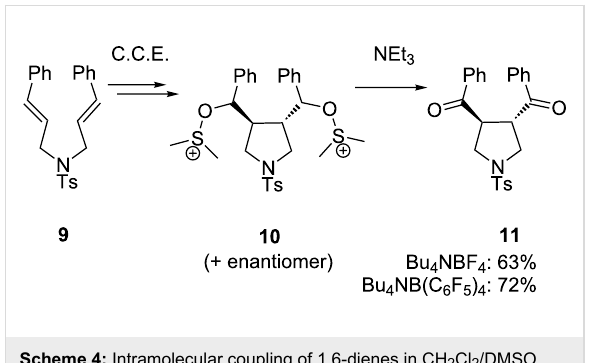
depicted in Scheme 3 are applied, including quenching with NEt 3 , exo–exo -cyclization product 11 is obtained in 63% yield with 100% trans -selectivity. The yield can be increased to 72% when Bu 4 NB(C 6 F 5 ) 4 is used as supporting electrolyte.